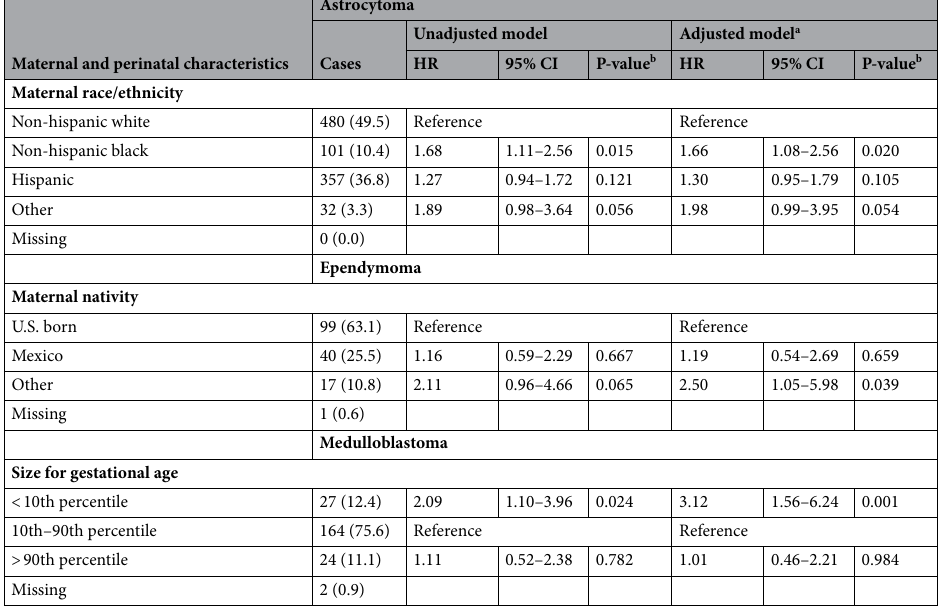
Table 5. Significant associations between maternal and perinatal factors and survival of pediatric astrocytoma, ependymoma, and medulloblastoma cases. a Adjusted for birth year, sex, maternal race/ethnicity, maternal education, tumor malignancy. b Bonferroni corrected reference P values: 0.003 for an experiment-wide significance of 0.05.